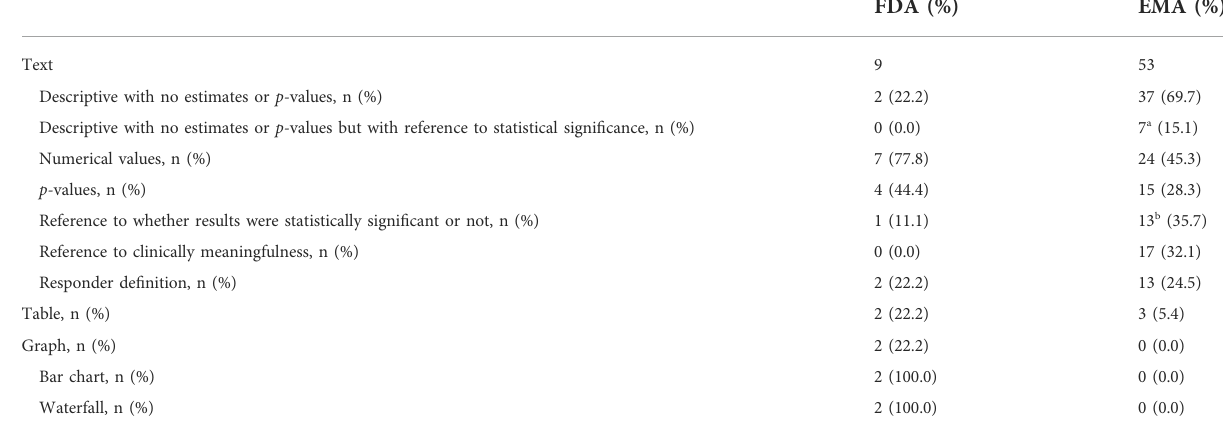
TABLE 2 Format used to communicate the PRO